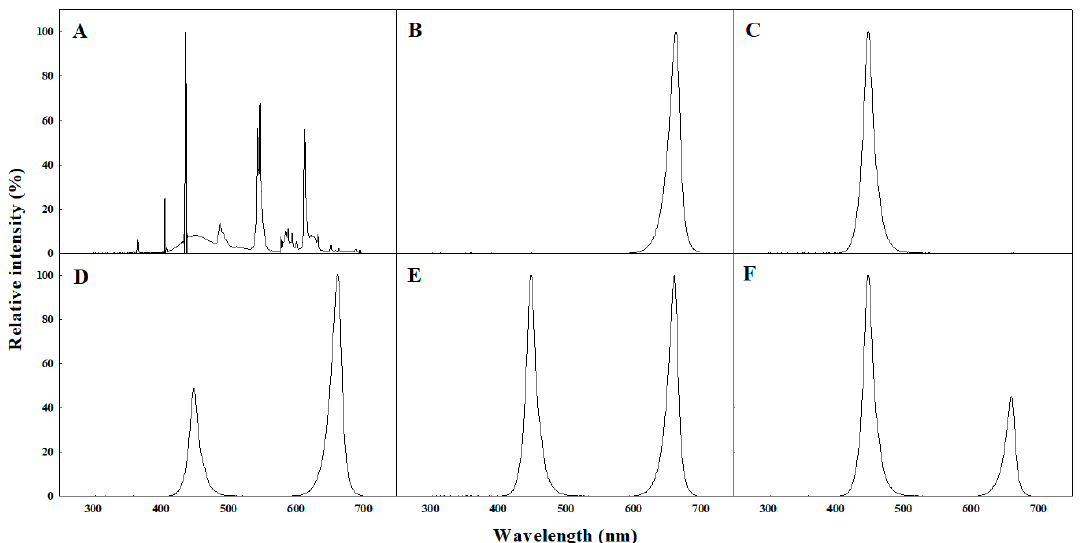
Figure 1. Relative spectral distribution of light used in a closed-type plant production system. ( A ) fluorescent lamp; ( B ) Red (red:blue = 10:0); ( C ) Blue (red:blue = 0:10); ( D ) R7B3 (red:blue = 7:3); ( E ) R5B5 (red:blue = 5:5); and ( F ) R3B7 (red:blue = 3:7).